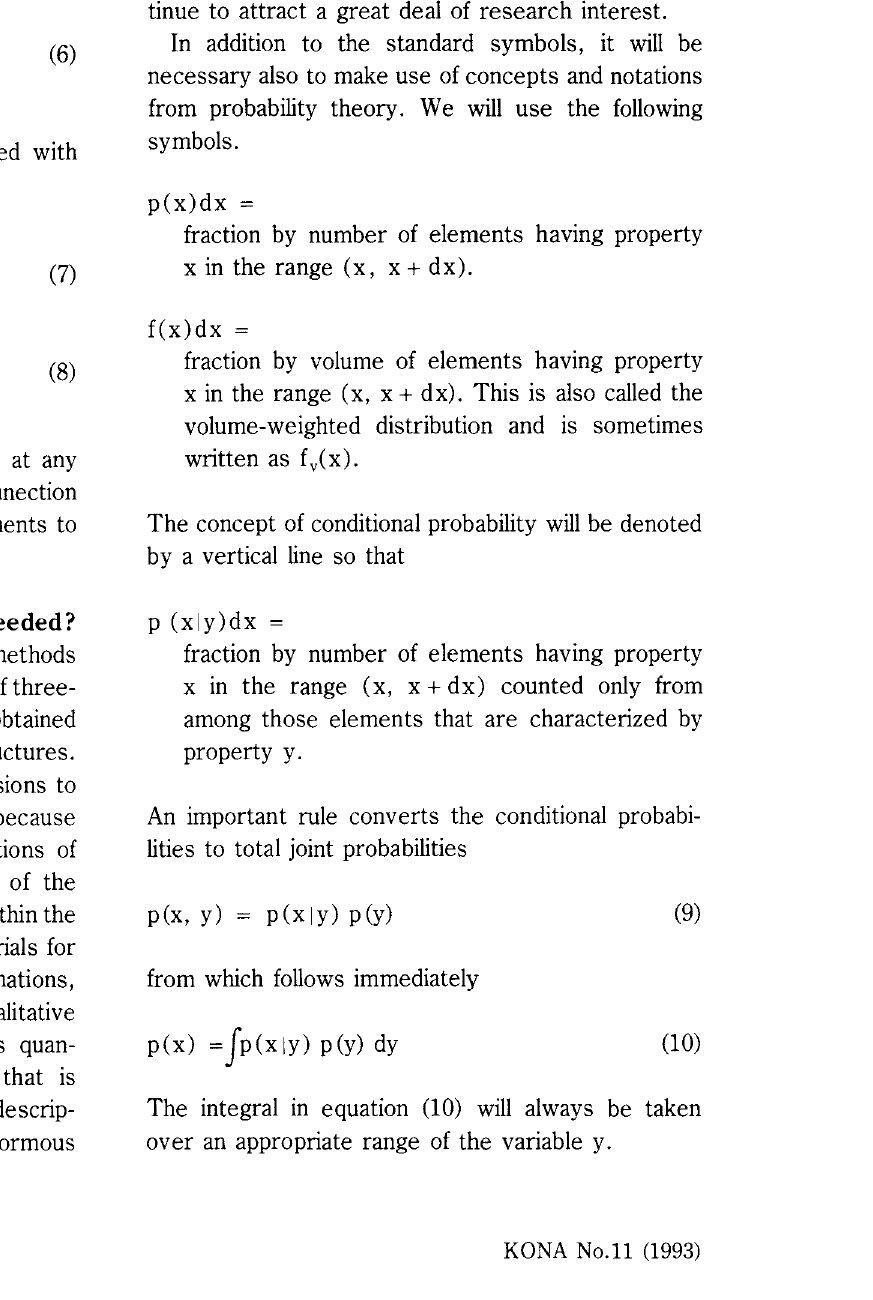
Fig. 7 Method for correcting measured perimeters for the fractal effect. ' with i =